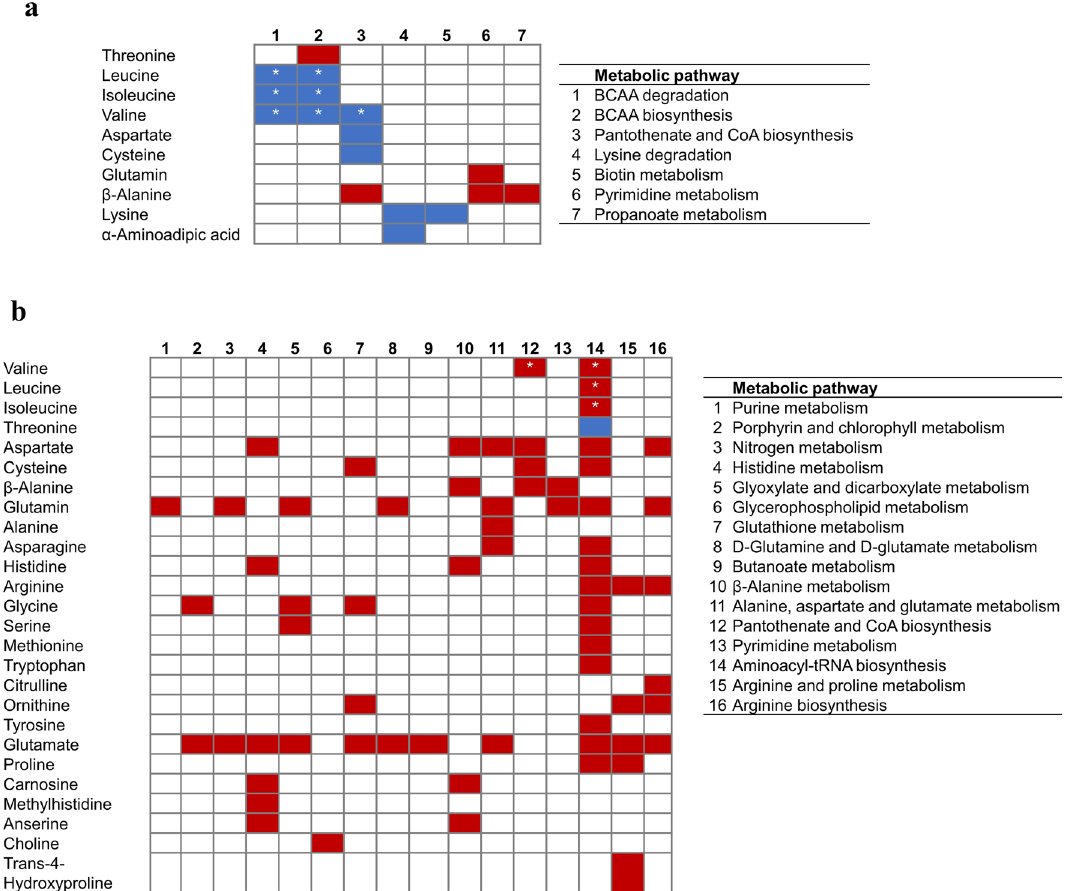
Figure 4. Effectively detected and quantified metabolites involved in metabolic pathways differing between RFI groups fed the corn ( a ) or the grass ( b ) diet. Metabolic pathways references are stated next to the correspondent panel. Significant differences (Tukey’s test < 0.05) between Low versus High-RFI within the given diet are depicted with *, whenever RFI × Diet interaction significant effect ( FDR < 0.05 in the ANOVA analysis). Cells’ color code depict metabolites concentrations for Low- versus High-RFI animals (red: increased, blue: